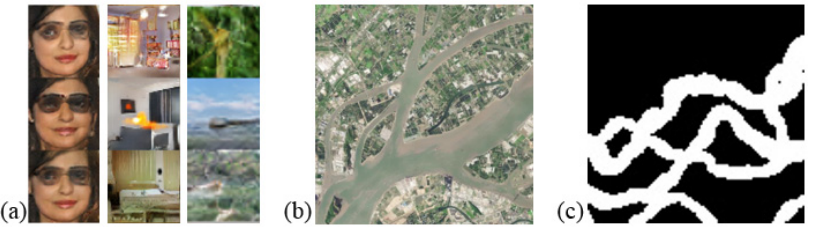
Figure 3. GANs is successfully applied in image generation and there are similarities between facies models and specific images. ( a ) Image generated by GANs [14]; ( b ) Remote sensing image of modern river channel; ( c ) Model of anastomosing river channel.